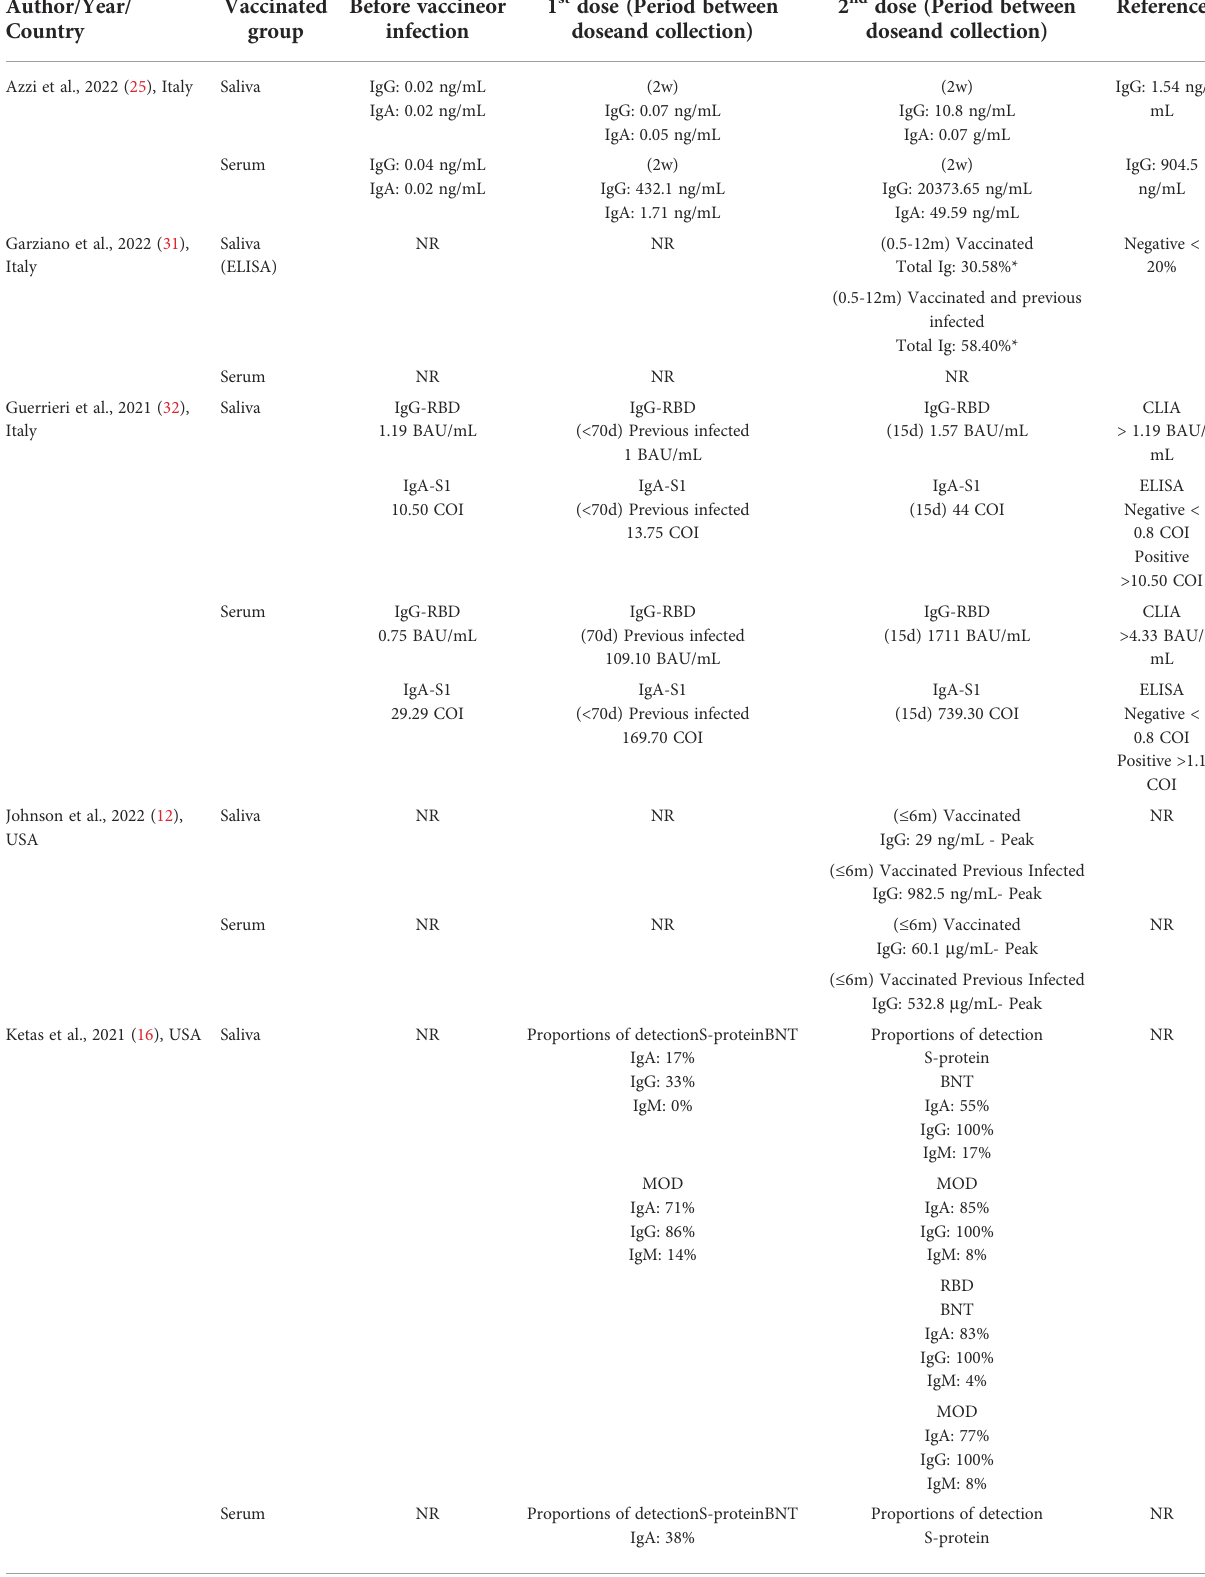
TABLE 2 Antibodies titers or proportion of detection in saliva versus serum/plasma of studies that expressly reported numerical data. Author/Year/